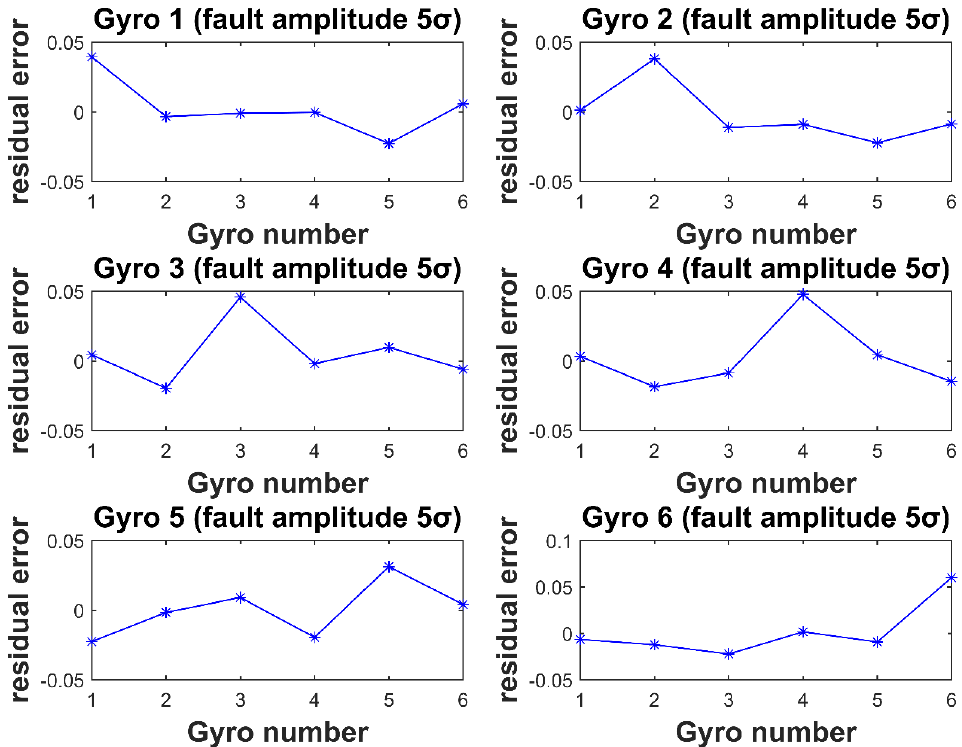
5  fault amplitude.